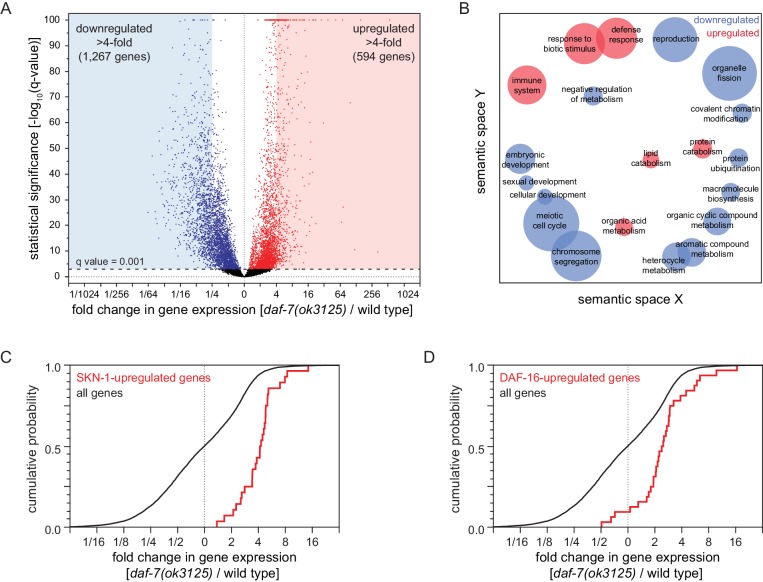
Reduced DAF-7/TGFβ signaling upregulates expression of DAF-16/FOXO and SKN-1/NRF target genes.(A) Volcano plot showing the level and statistical significance of changes in gene expression induced by the daf-7(ok3125) null mutation. Genes up- and down-regulated significantly (q value < 0.001) are shown in red and blue, respectively. (B) Gene Ontology (GO) term enrichment analysis of biological processes associated with the set of 594 upregulated genes (blue bubbles) and the set of 1267 downregulated genes (red bubbles) with a statistically significant and greater than four-fold change in expression in daf-7(ok3125) mutants relative to wild-type animals. Bubble size is proportional to the statistical significance [-log10(P value)] of enrichment. (C) The daf-7(ok3125) mutation increased the expression of genes upregulated by skn-1(+) in wild type animals (Oliveira et al., 2009). (D) The daf-7(ok3125) mutation increased the expression of genes directly upregulated by DAF-16 (Kumar et al., 2015). See also Figure 6—figure supplement 1. Additional statistical analyses are in Supplementary file 6.